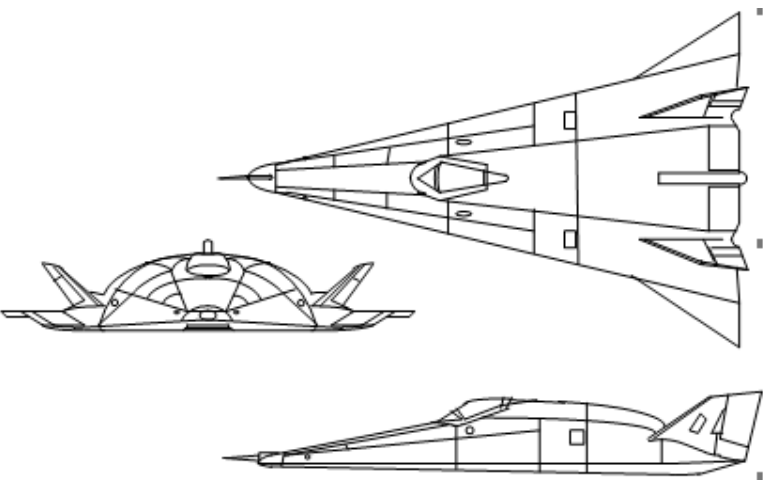
Figure 1. Three views of a near-space hypersonic vehicle.